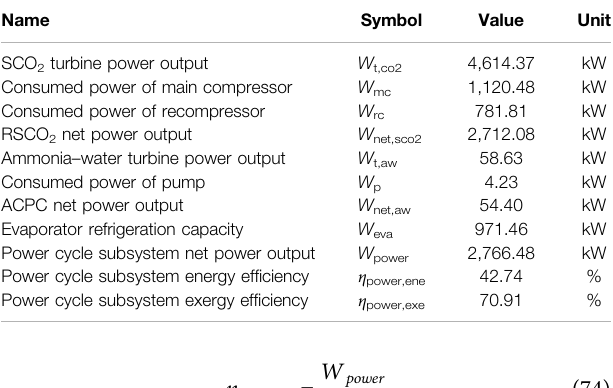
TABLE 5 | System baseline simulation result of power cycle subsystem performance.